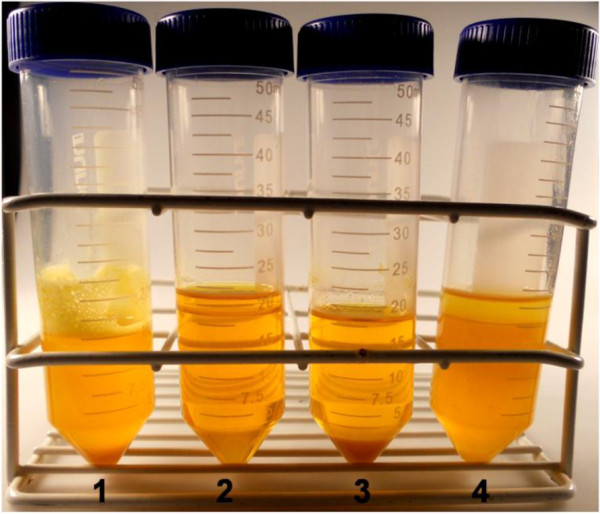
Dissolving effect of methanol on oil gums. (1) Soybean oil (raw material); (2) soybean oil with 1.5 eqs MeOH; (3) soybean oil acid degummed; and (4) soybean oil acid degummed with 1.5 eqs MeOH. Image obtained after 24 h incubation at 35°C, 250 rpm agitation, and centrifugation at 2,000 rpm for 5 min.